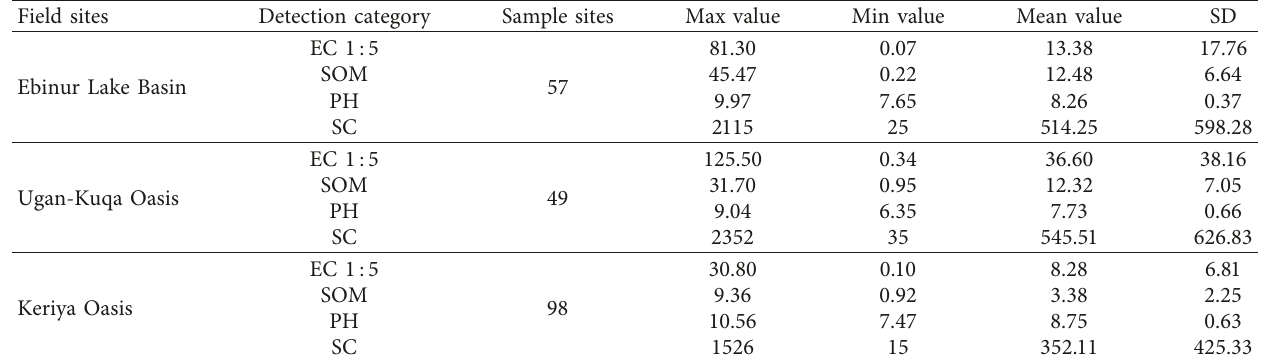
Table 3: Statistical analysis of chemical composition measurement in sampling area soil.